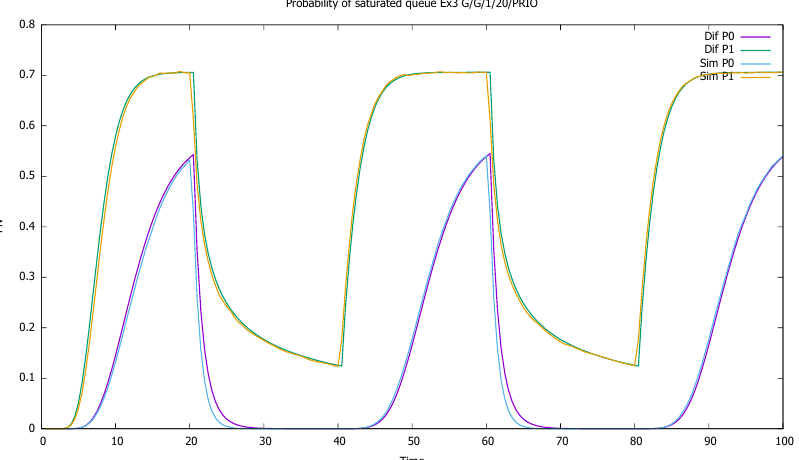
Figure 12. Section 3.3, high load: probabilities of saturated queues for priority (P0) and non-priority (P1)